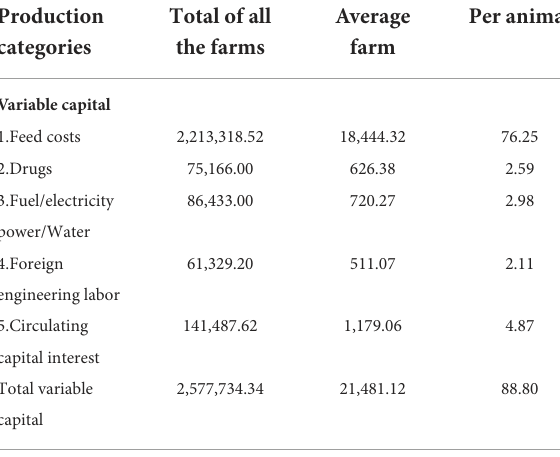
TABLE 4 Variable capital